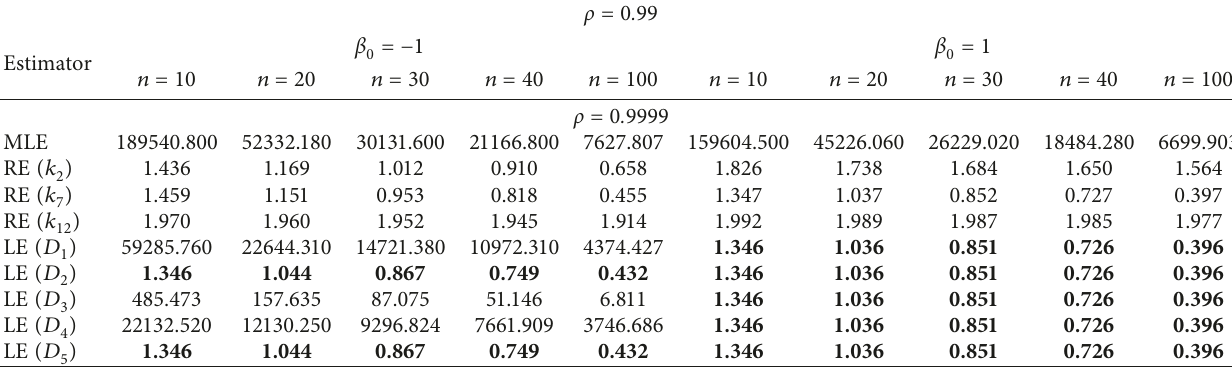
when δ � 0 . 04 , α � 0 . 25 , and p � 4. 0 ρ � 0 .